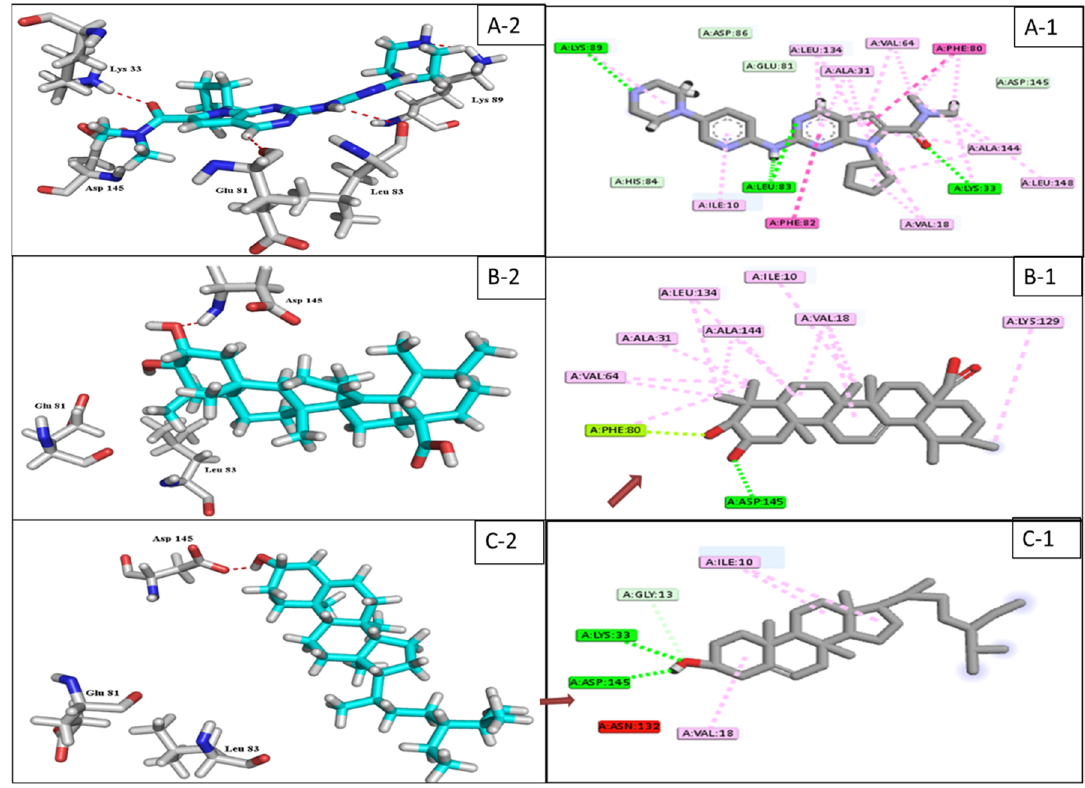
Figure 3. 2D & 3D interaction of the top docking pose of ribociclib ( A-1 , A-2 ), compound 3 ( B-1 , B-2 ) and compound 1 ( C-1 , C-2 ) at the catalytic domain of CDK-2 enzyme.